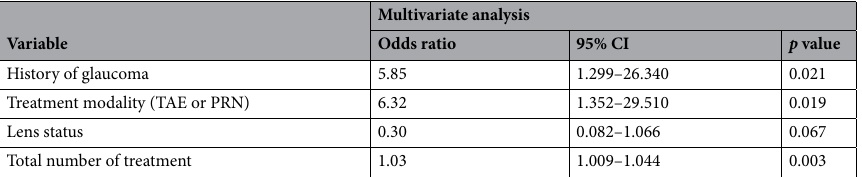
Table 3. Logistic analyses which investigate factors influencing elevated IOP. Excluded variables: age, sex, follow-up period. IOP intraocular pressure, CI confidential interval, TAE treat and extend, PRN pro re